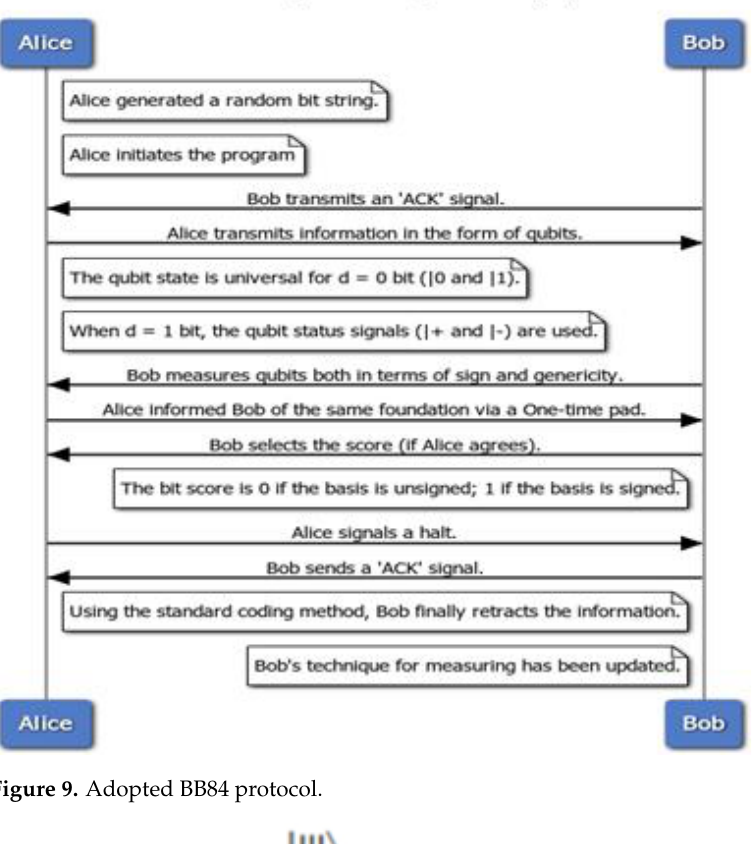
Figure 9. Adopted BB84 protocol.